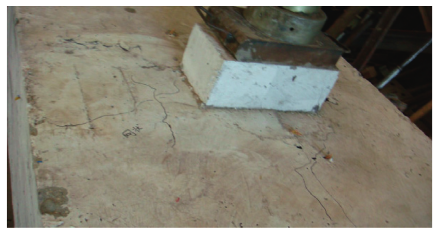
Figure 12: Crack diagram of top.